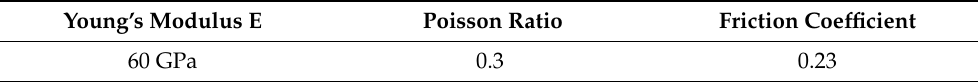
Table 1. Summary of materials constants and friction